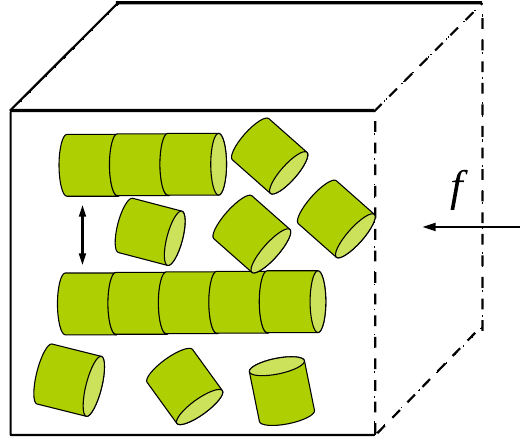
Figure 2. Schematic diagram of the cubical box, containing a bundle of filaments growing by a diffusion- limited reaction used in Brownian dynamics simulations. One face of the cubical box facing the filament tip is movable (the barrier); it is acted on by a constant force f in the backward direction and also undergoes random motion characterised by diffusion coefficient D w